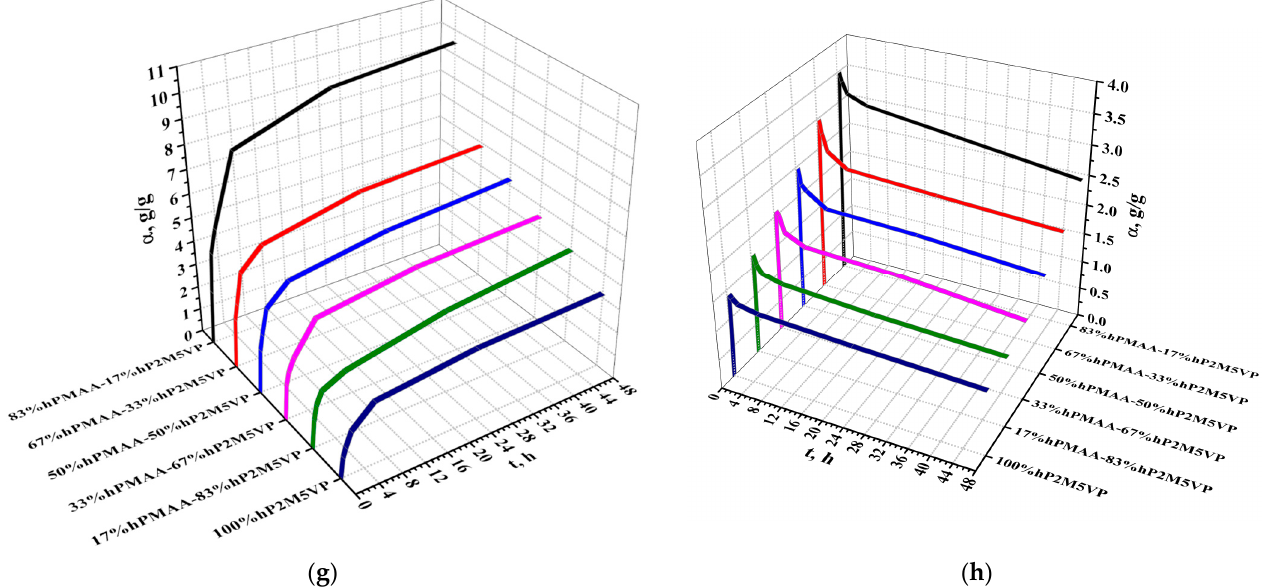
Figure 4. Swelling degree of basic hydrogels in aqueous medium ( a , c , e , g ) and lanthanum nitrate ( b , d , f , h ).